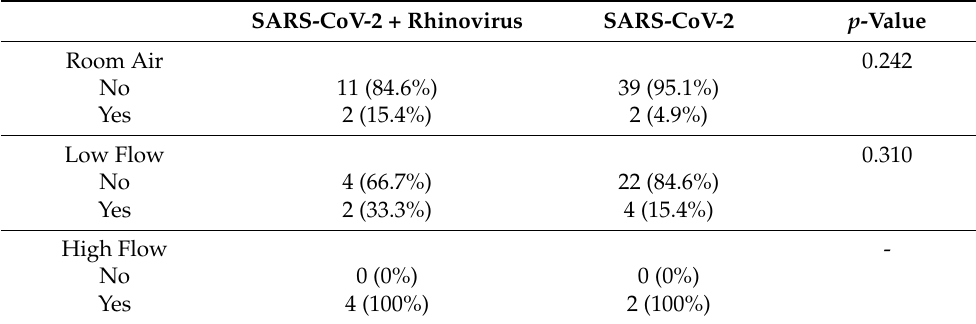
Table 4. 30-day all-cause mortality between adults with SARS-CoV-2 + rhinovirus infection or SARS-CoV-2 mono-infection stratified by baseline oxygen support.